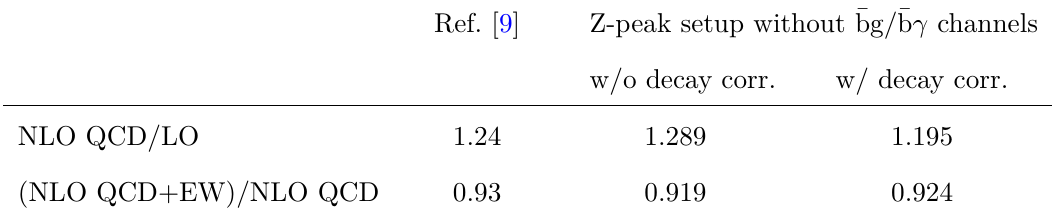
Table 3. Comparison with results denoted as t ‘ + ‘ − j (Z-peak, 5FS) in table 2 of ref. [9]. The corrections to the semi-leptonic top decay are subtracted from our predictions in column 3 but not in column 4. Contributions of the ¯ bg and ¯ b γ channels are omitted in columns 3 and 4.